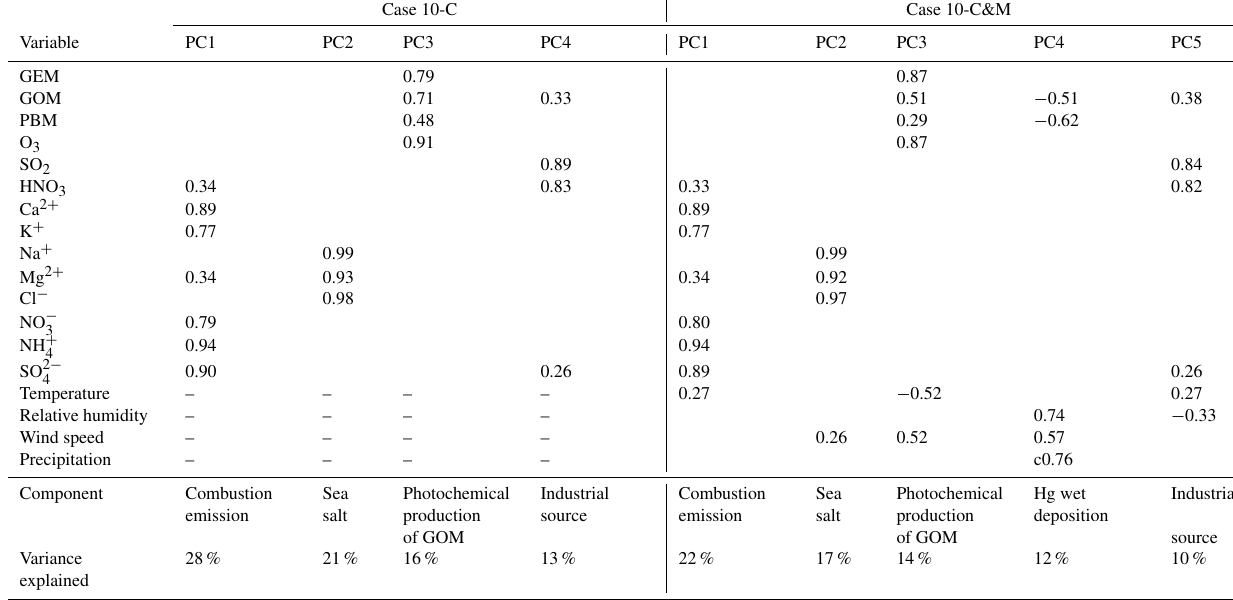
Table 8. PCA component loadings (>0.25) of Case 10-C and Case